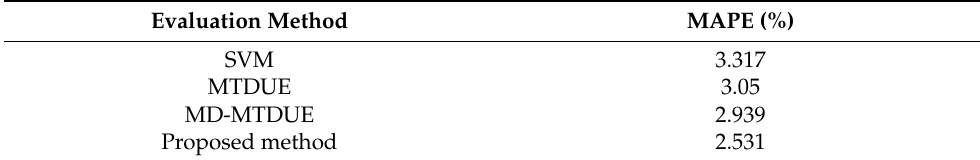
Table 3. MAPE value of the model with and without the addition of virtual samples.